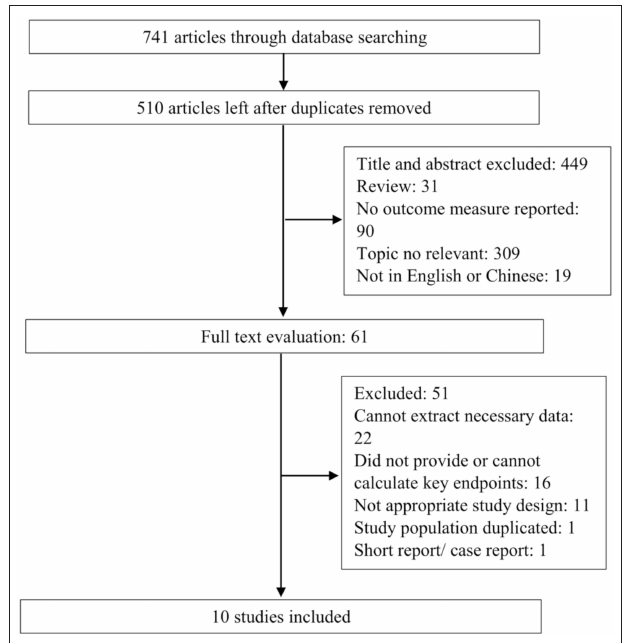
FIGURE 1 | Flowchart of the study selection